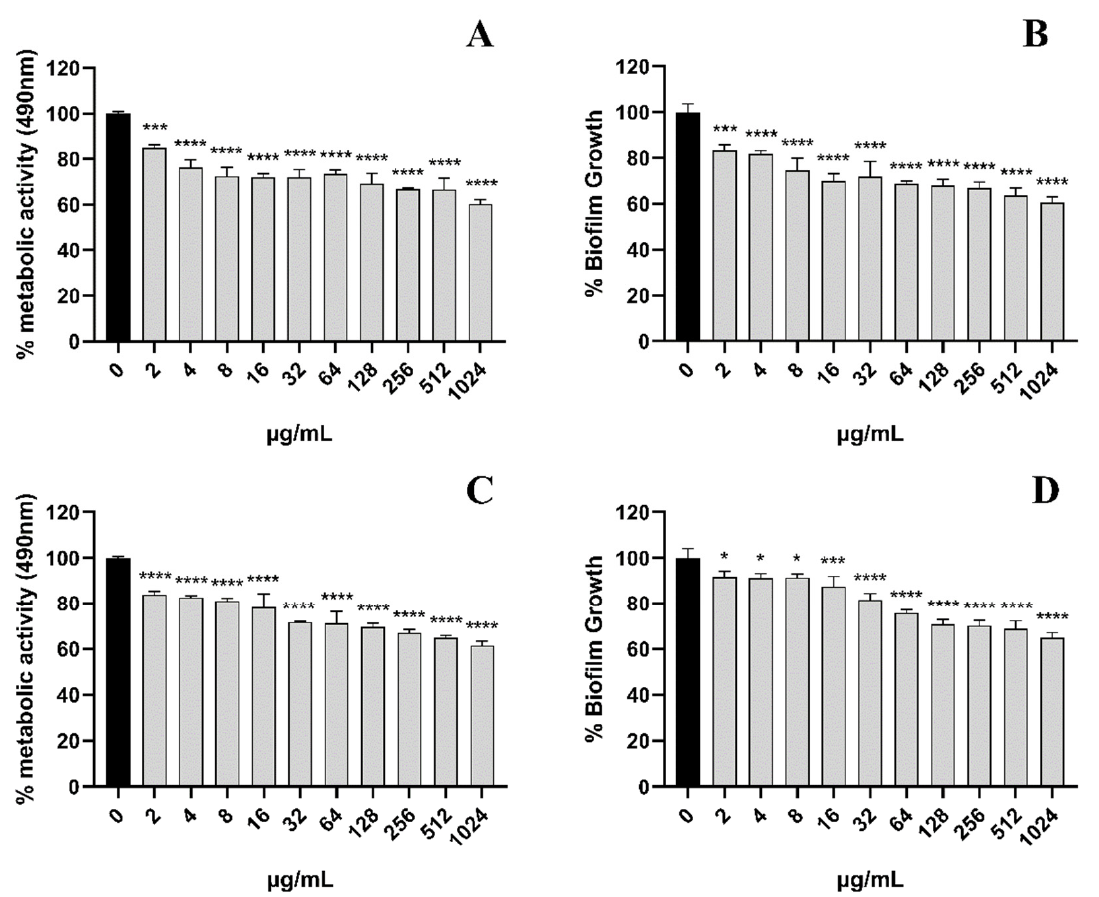
Figure 4. The scavenging effect of EA on the C. albicans 24 ‐ h early biofilm and 48 ‐ h mature biofilm. The clearance of 24 ‐ h early biofilm formation of C. albicans by various concentrations of EA as measured by XTT dye ( A ) and 1% CV ( B ). The 48 ‐ h mature biofilm of C. albicans eradication as measured by XTT dye ( C ) and 1% CV ( D ). Values are expressed as mean SD; n = 3; * p < 0.05, *** p < 0.001, and **** p < 0.0001 when compared to the control.